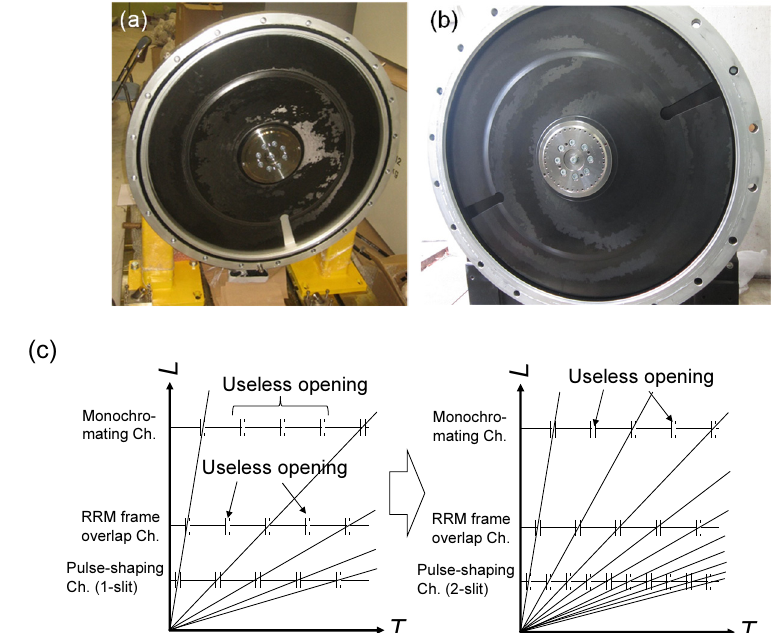
Fig. 6. Disks for the pulse shaping chopper of AMATERAS. (a) A single slit disk, which is currently used. (b) A double slit disk newly prepared (on a test-bench). (c) Schematic image of improvement by doubling the slit of the pulse shaping chopper at AMATERAS. In (c), L and T stand for the flight path length and the time-of-flight,